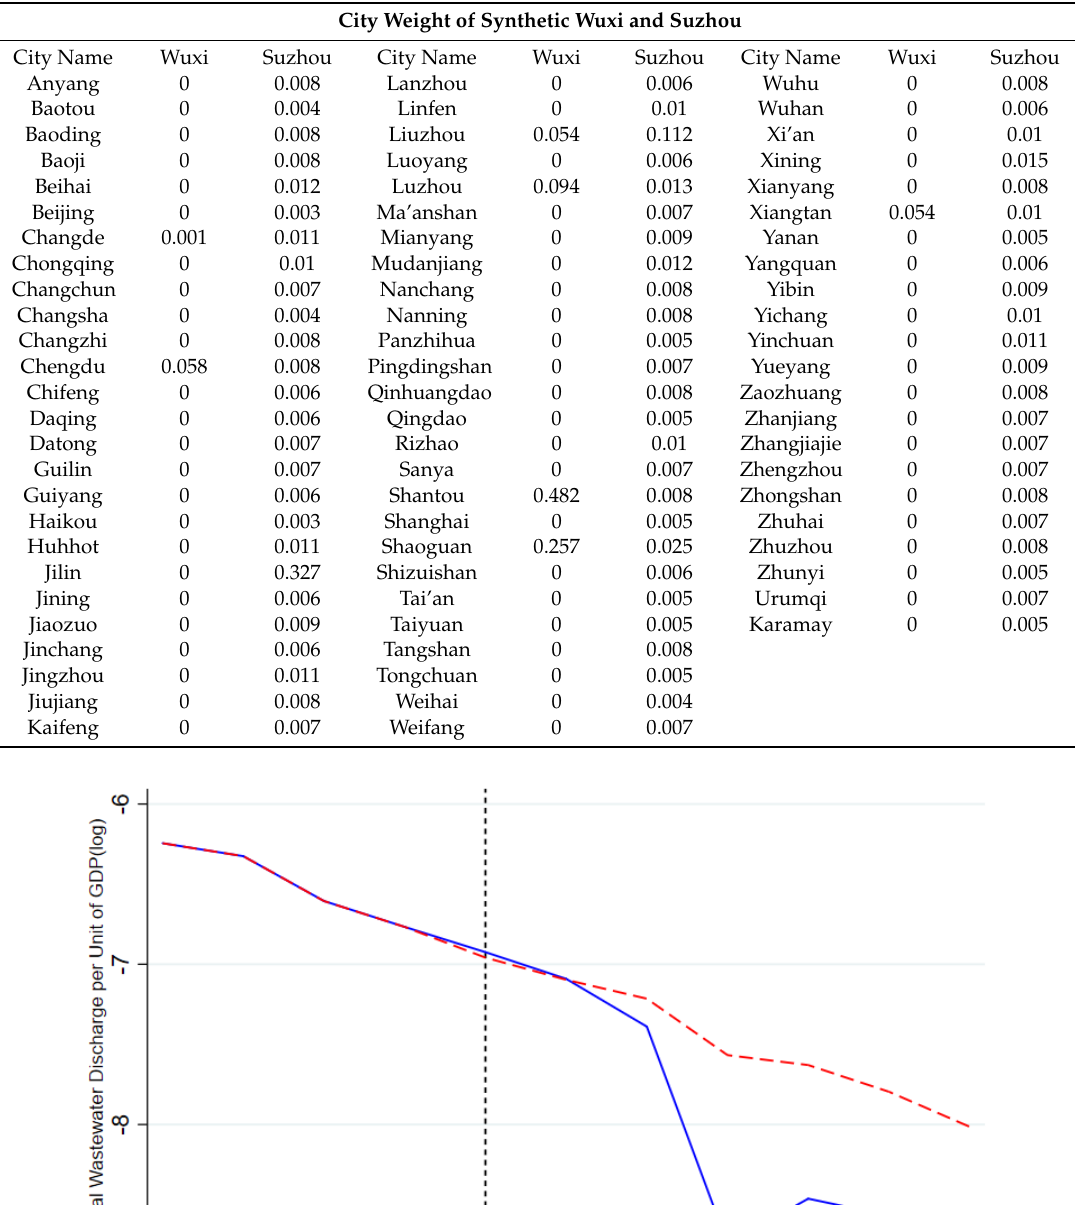
Table 8. City weights of synthetic Wuxi and Suzhou.